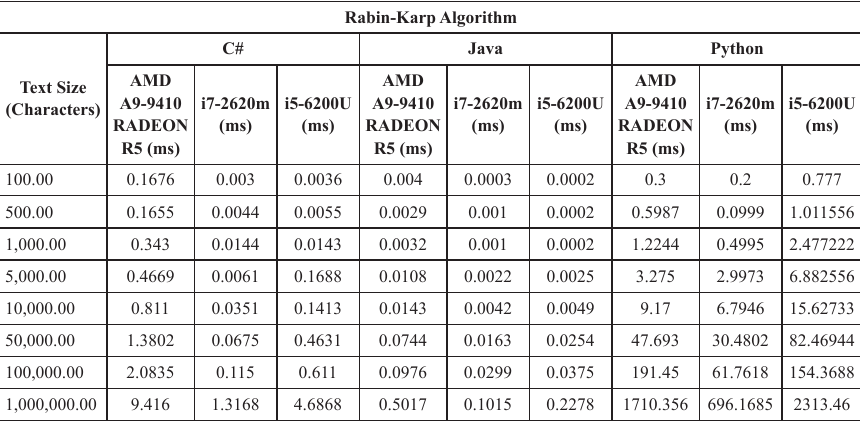
Table 3. Running time of Rabin-Karp algorithm in C#, Java